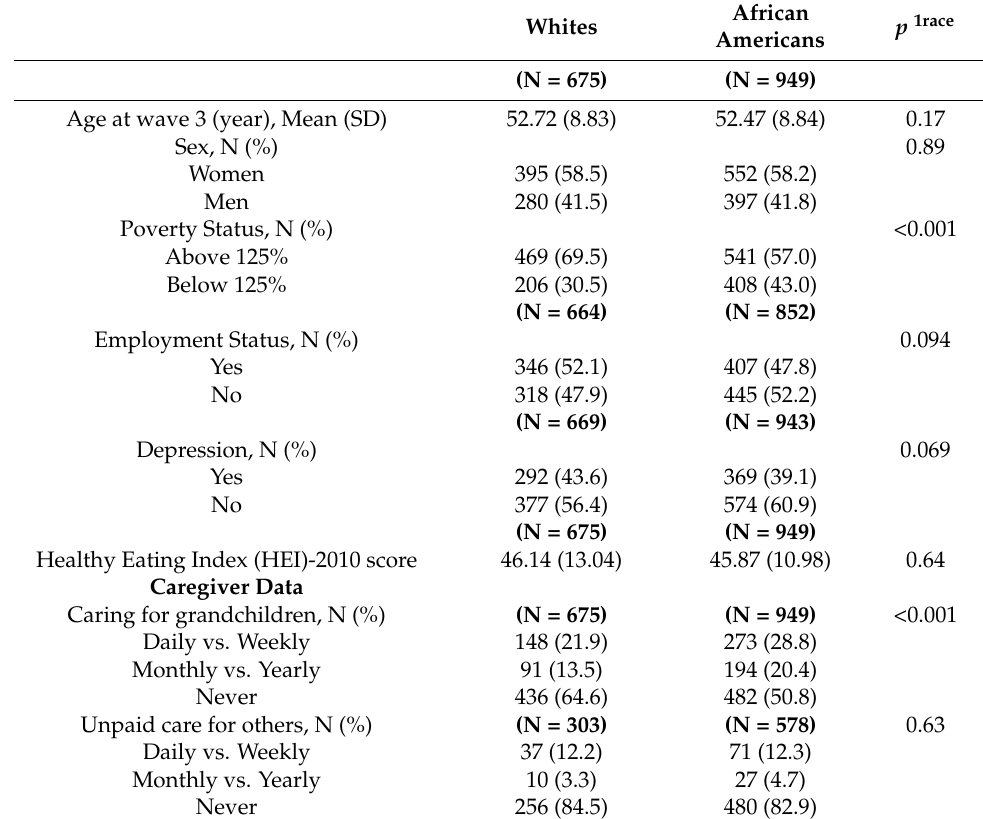
Table 1. Characteristics of Healthy Aging in Neighborhoods of Diversity Across the Life Span (HANDLS) participants at wave 3 (N =